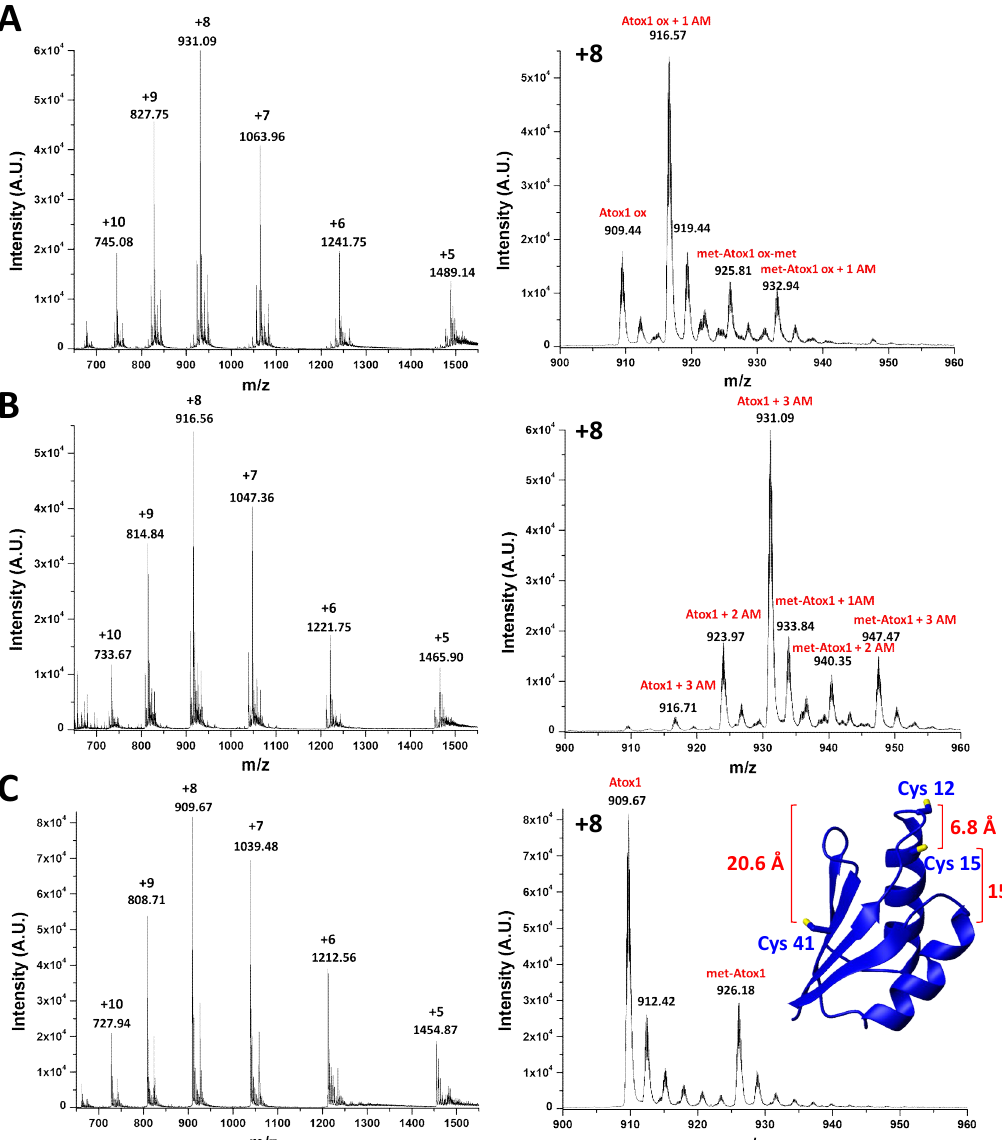
Figure 1. Electrospray mass spectrometry (ESI-MS) spectra of oxidized ( A ) and reduced ( B ) Atox1 treated with three equivalents of 2-iodoacetamide (IAM) and ESI-MS spectrum of the untreated reduced Atox1 ( C ). The spectra show two sets of peaks corresponding to the expected total masses with or without cleavage of the N-terminal methionine (met, 131 Da) of Atox1. (Inset) Average interatomic distances between sulfur atoms of cysteines residues of Atox1, displayed on the lowest energy structure of the reduced apoprotein (PDB ID 1tl5).